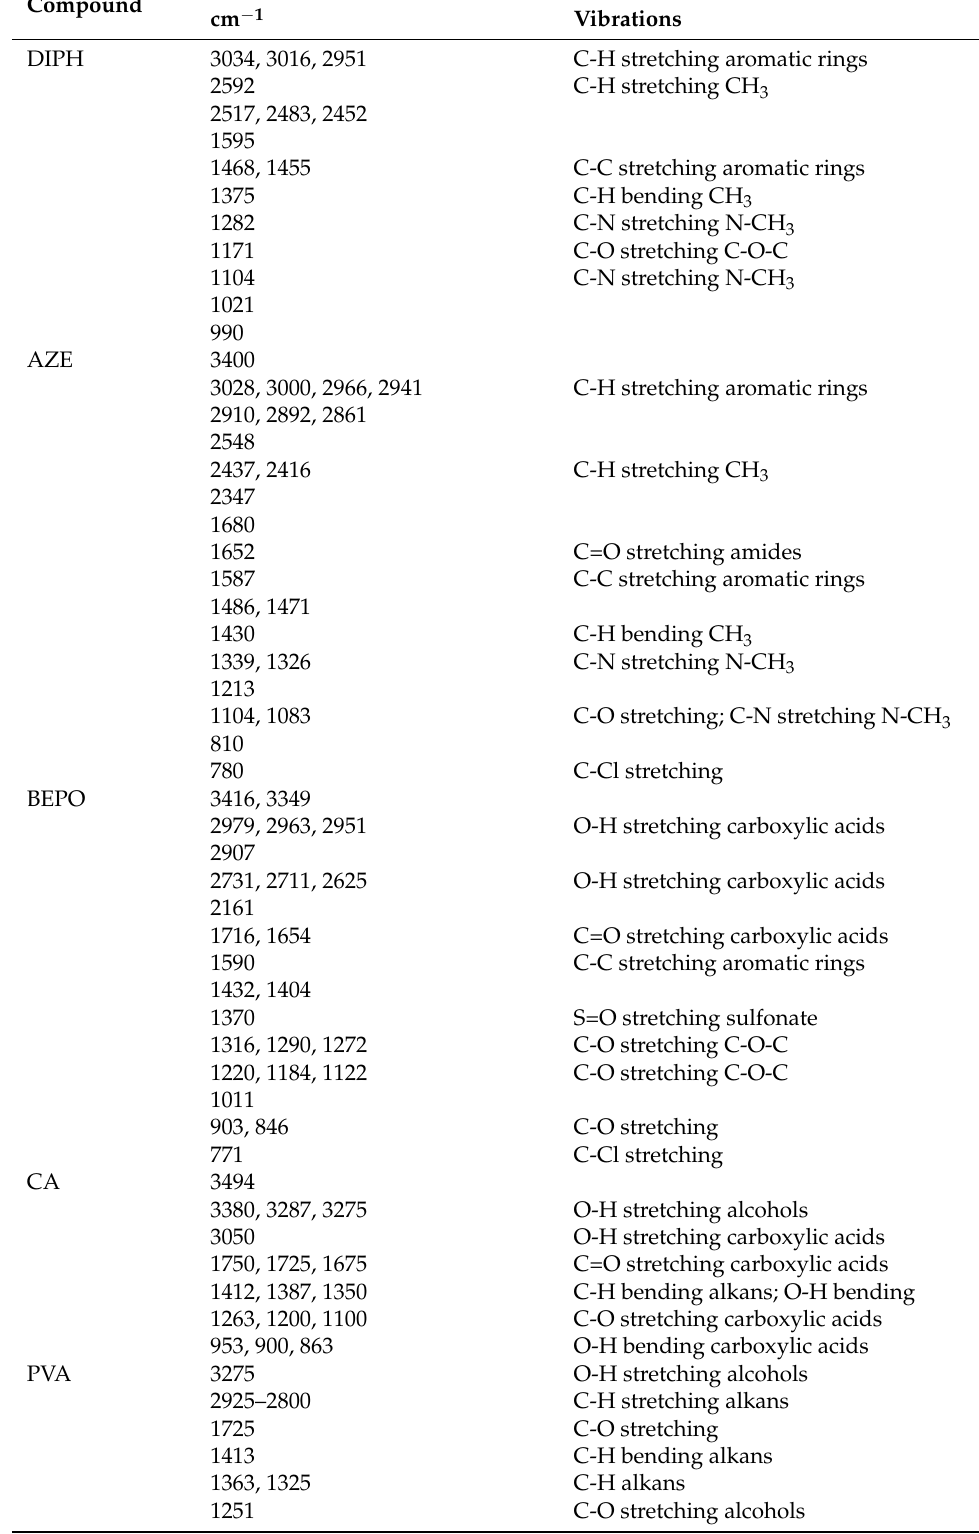
Table 4. FT-IR characteristic of diphenhydramine (DIPH), azelastine (AZE) and bepotastine (BEPO).